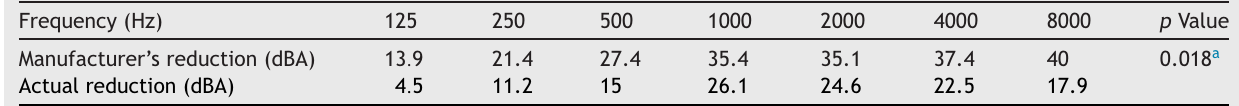
Comparison of noise reduction by frequency band: noise reduction suggested by the manufacturer versus attenuation measured in actual situation